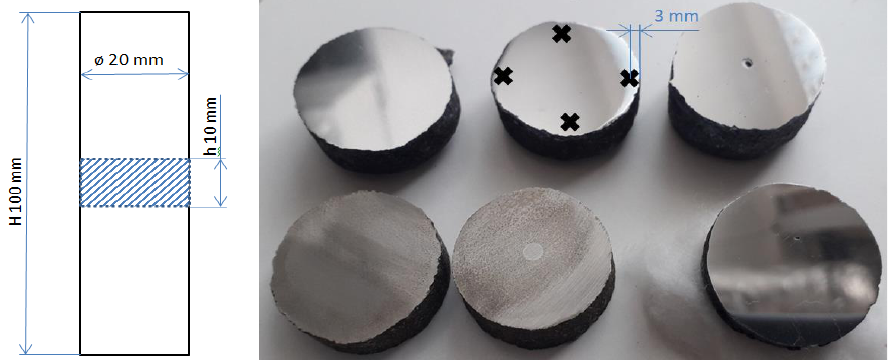
Figure 1. Diagram of sections of samples from cast blanks for hardness measurements, wear tests, and shock–dynamic impact (the points of surface hardness measurement are marked on the cutting surface with a × sign).